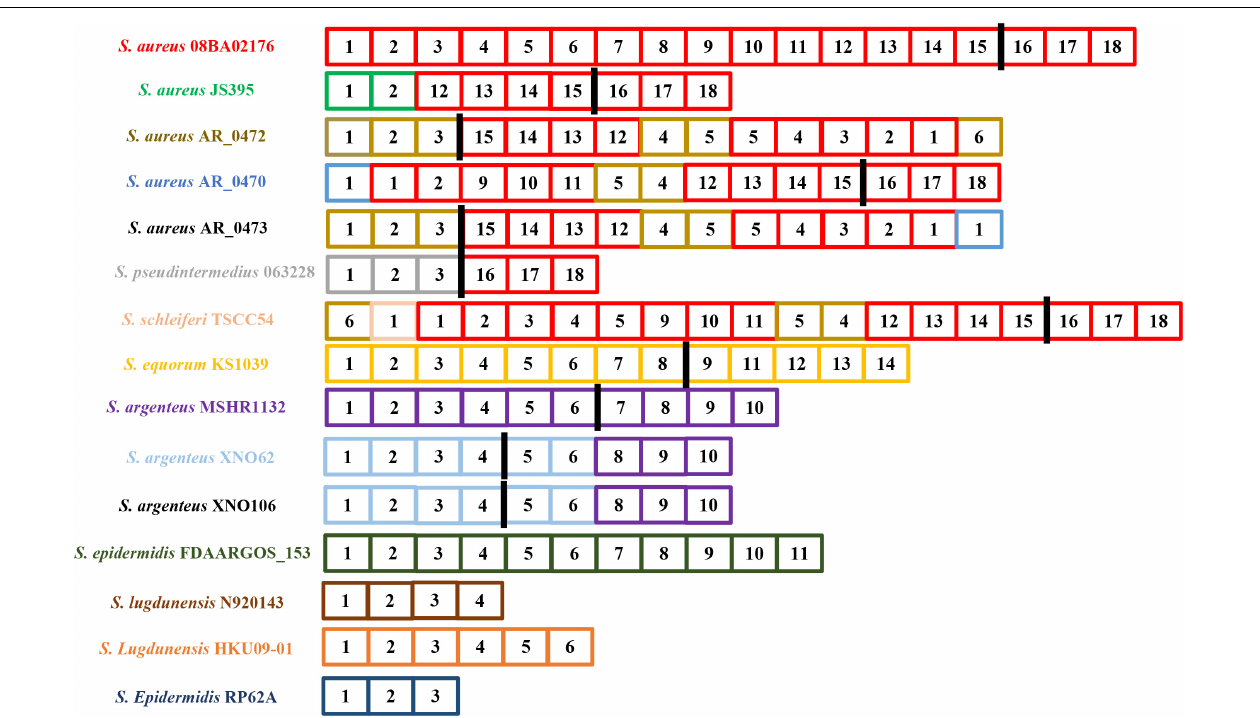
FIGURE 3 | Graphic representation of spacers in the CRISPR loci flanking the complete Cas proteins. The strains shown in the figure all contain a complete type III-A CRISPR system. Repeats are not included. Two spacers are the same one when their diversity in DNA sequence is less than 5%. Each spacer consists of a small square, a number (continuously numbered in a strain), and a specific background color. The black rectangle represents the Cas cluster. The bacteria on the left are labeled as the color of the spacer as it originally appeared in its CRISPR locus. The strain labeled black indicates that there is no new spacer at its CRISPR locus.